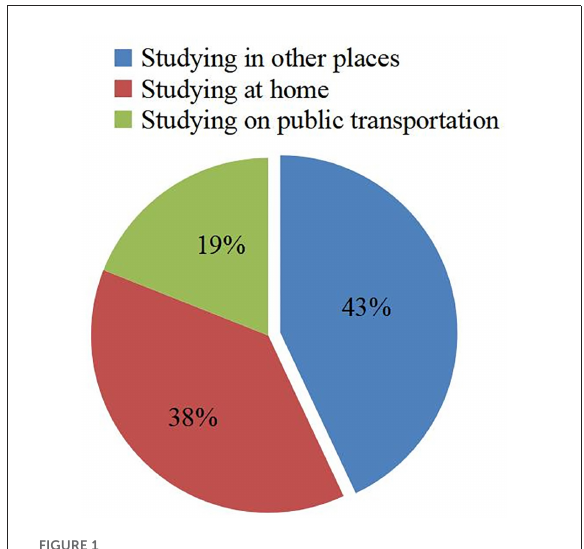
FIGURE1 Non-classroom learning for mobile applications users.